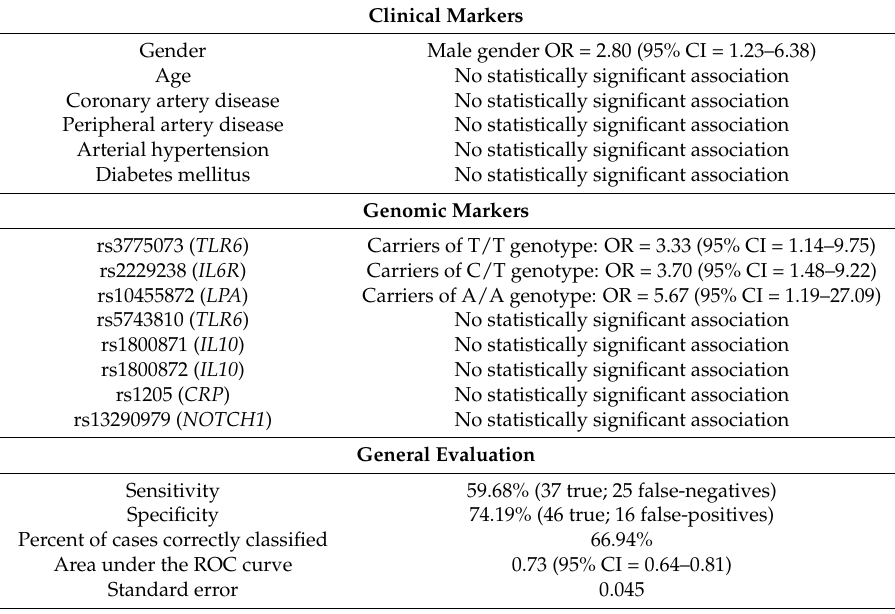
Table 2. Brief description of the model predicting the risk of severe bioprosthetic mitral valve calcification after mitral valve replacement surgery, calculated by stepwise logistic